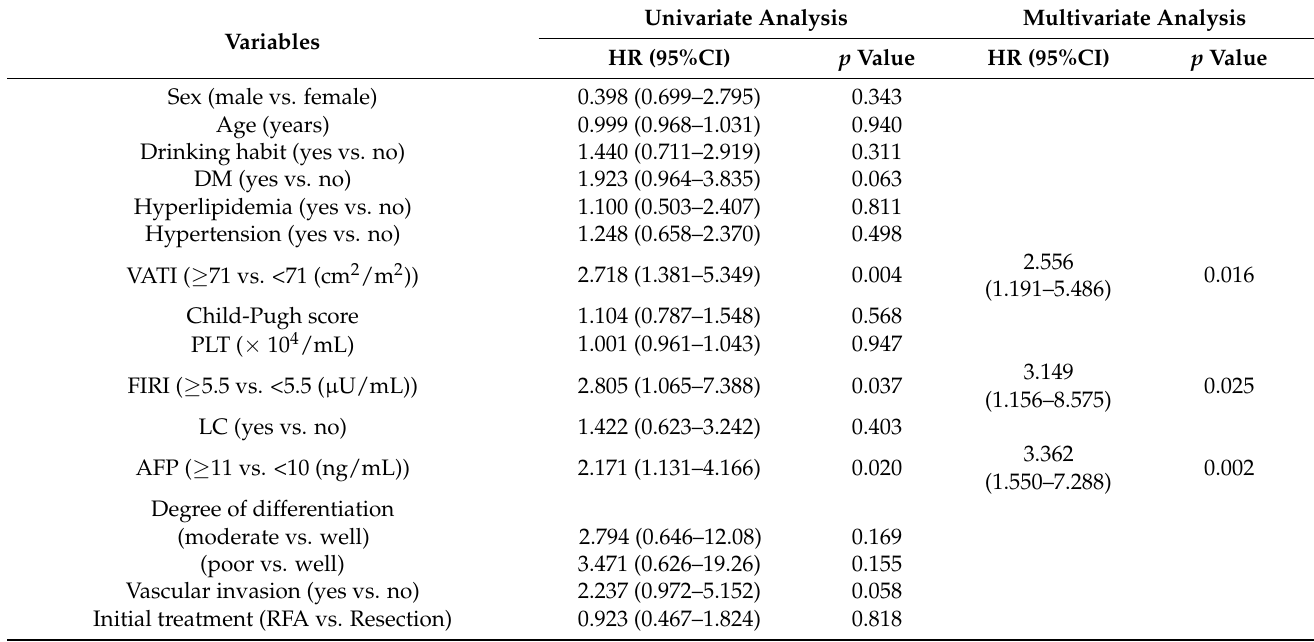
Table 2. Univariate and multivariate analyses of possible risk factors affecting recurrence-free survival of non-B non-C HCC by Cox proportional hazards